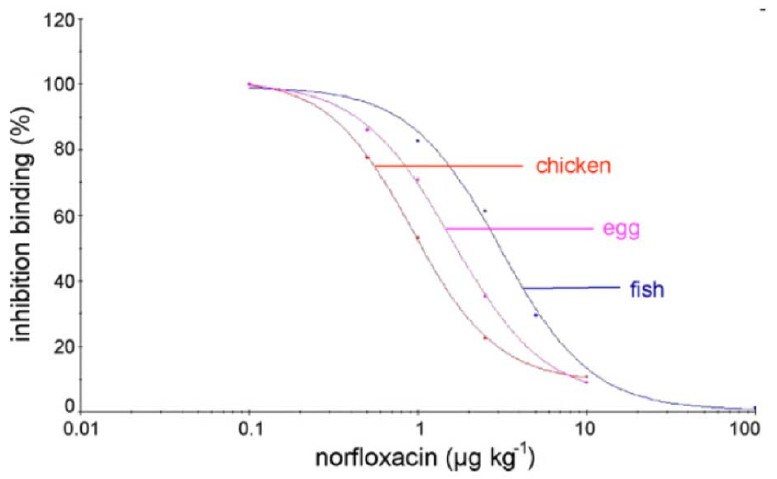
Figure 8. Assay standard curves for norfloxacin detection in chicken meat, egg and fish. Reprinted from reference [85], with permission from Elsevier. Copyright